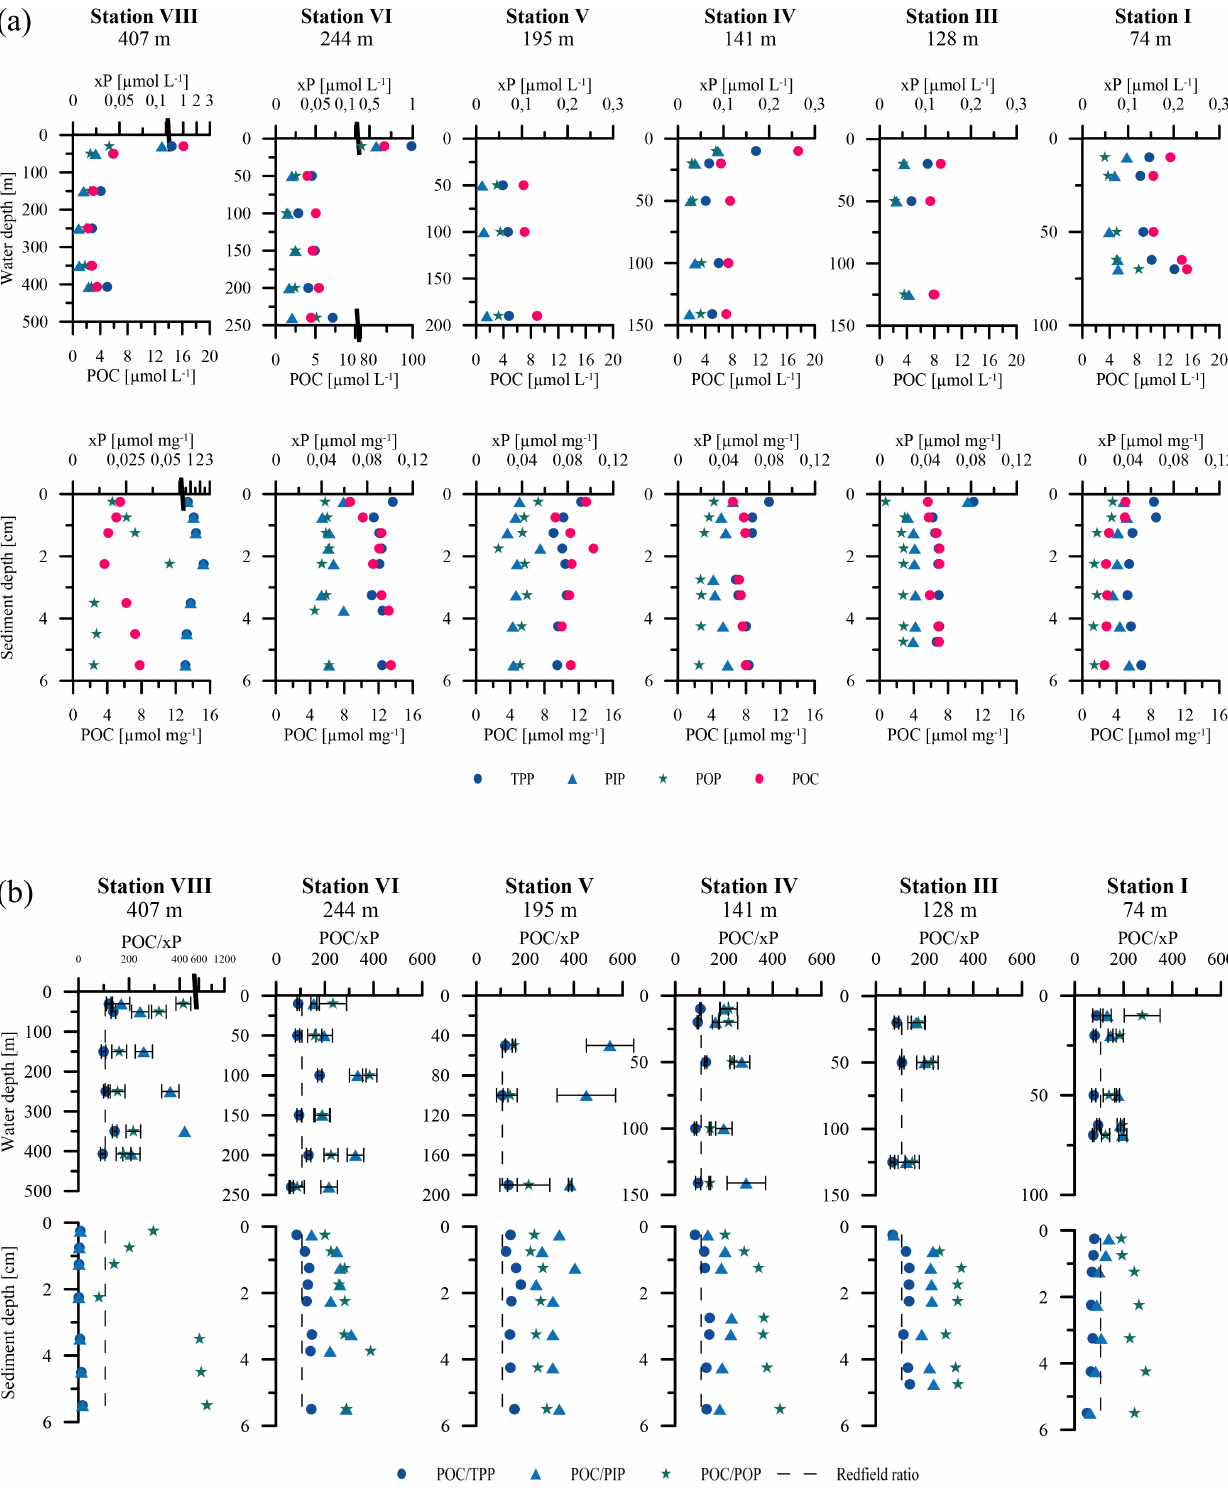
Figure 2. (a) Concentration profiles of TPP, PIP, POP, and POC of the water-column particles and the surface sediments along the 12 ◦ S transect. Water-column particle concentrations (upper panel) are given in µmolL − 1 and surface sediment concentrations (lower panel) are shown inµmolmg − 1 . Note that the water-column particle concentrations shown for station VI (244m) at 10m water depth are ∼ 5 times higher than at the other stations. (b) Ratios of POC to TPP, PIP, and POP (POC /x P) along the 12 ◦ S depth transect of water-column particles and surface sediments (0–5.5cm depth) of station I to VIII (74 to